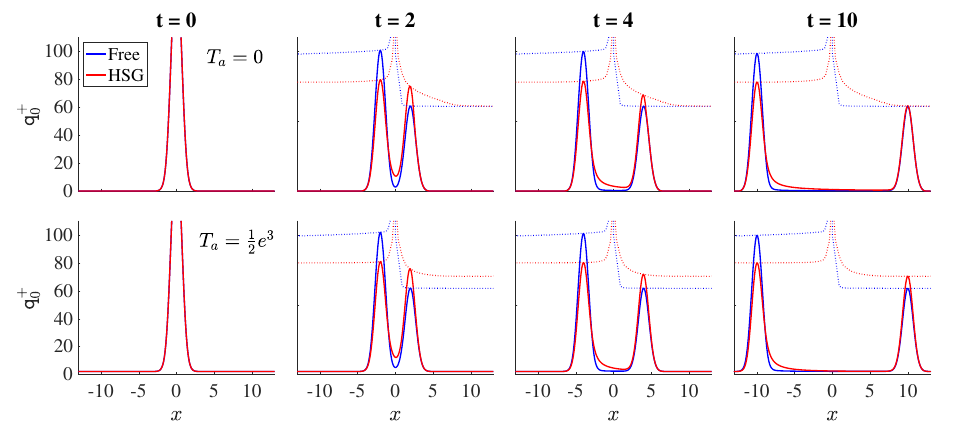
p x , t , θ q (red) versus p